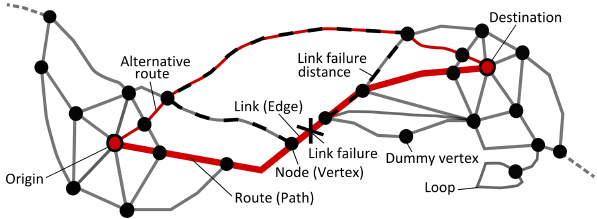
Figure 3. Example of a road network including terms used in this